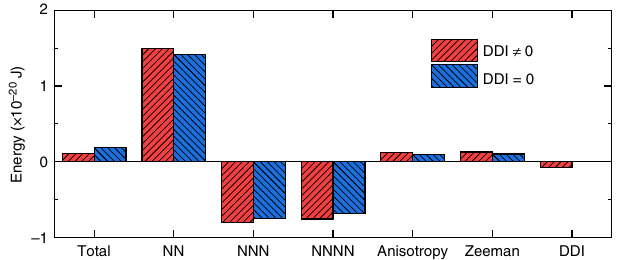
Fig. 3 Details of the micromagnetic energy of a relaxed (1, π /2)-skyrmion in the presence and absence of the DDI. The contribution from the DDI energy is found to be comparable to the anisotropy or Zeeman energy. The skyrmion energy is determined by the energy difference between the sample with a skyrmion and the sample without a skyrmion (i.e., with the FM